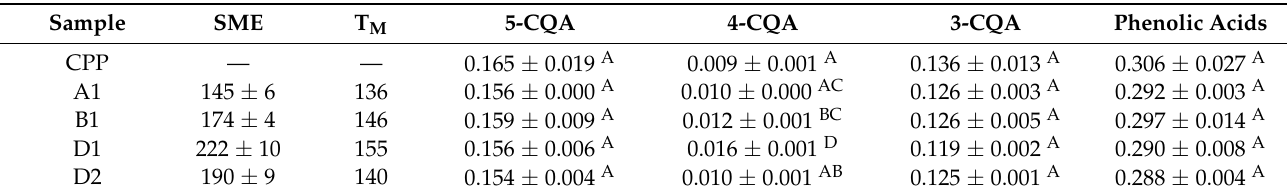
Table 7. Phenolic acids contents of chokeberry pomace powder (CPP) and samples after extrusion processing (g/100 g dm, mean ± SD, n = 2) at water contents of 13% (A1, B1, and D1) and 23% (D2), respectively. SME, specific mechanical energy (Whkg − 1 ); T M , material temperature ( ◦ C); 5 CQA, 5-caffeoylquinic acids acid; 4-CQA, 4-caffeoylquinic acids acid; 3-CQA, 3-caffeoylquinic acids